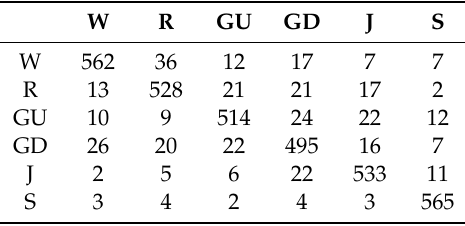
Table 10. Confusion matrix for DMGSOSEN-based HAR on the data from the left wrist when the initial pool size is 100.